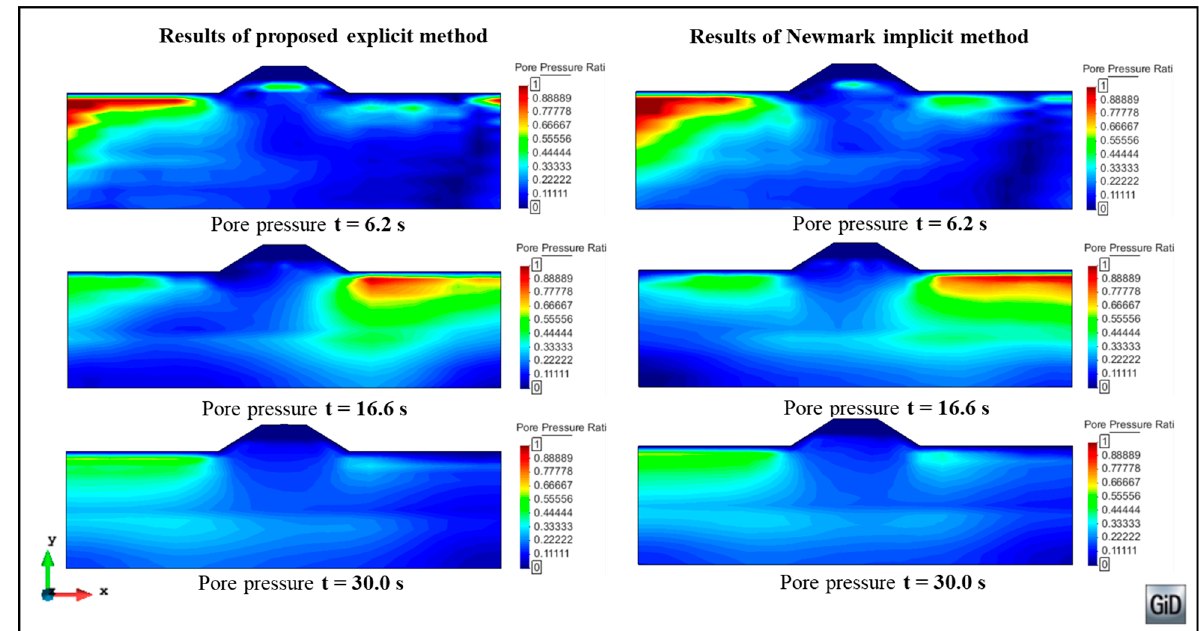
Figure 13. Contour plots of pore pressure ratio of the model.